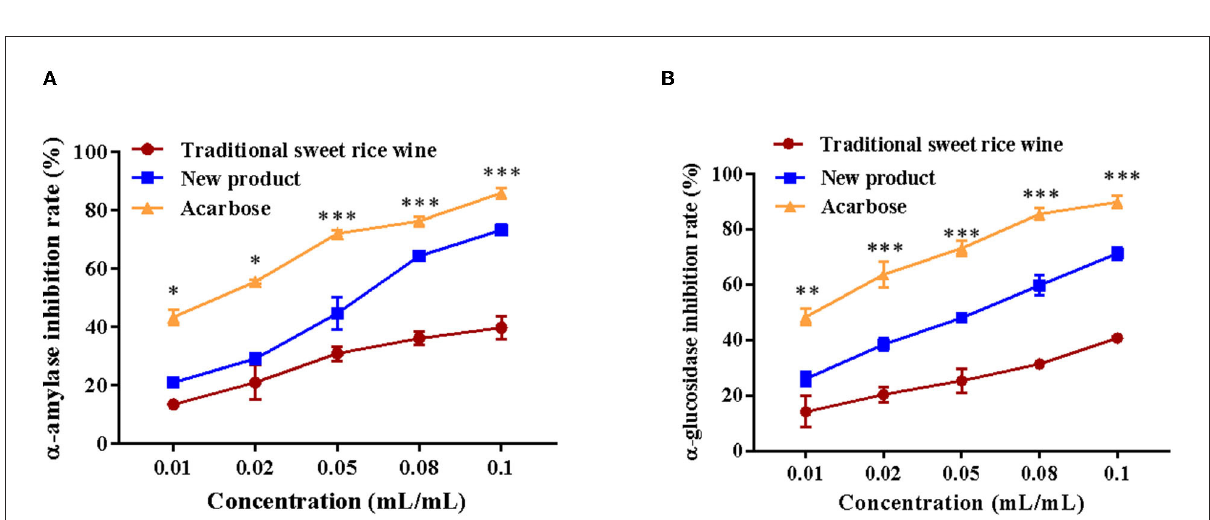
FIGURE7 Inhibitory effects on α -amylase (A) and α -glucosidase (B) of traditional sweet rice wine, new product and acarbose ( n = 3). ** p < 0.01; *** p < 0.001.